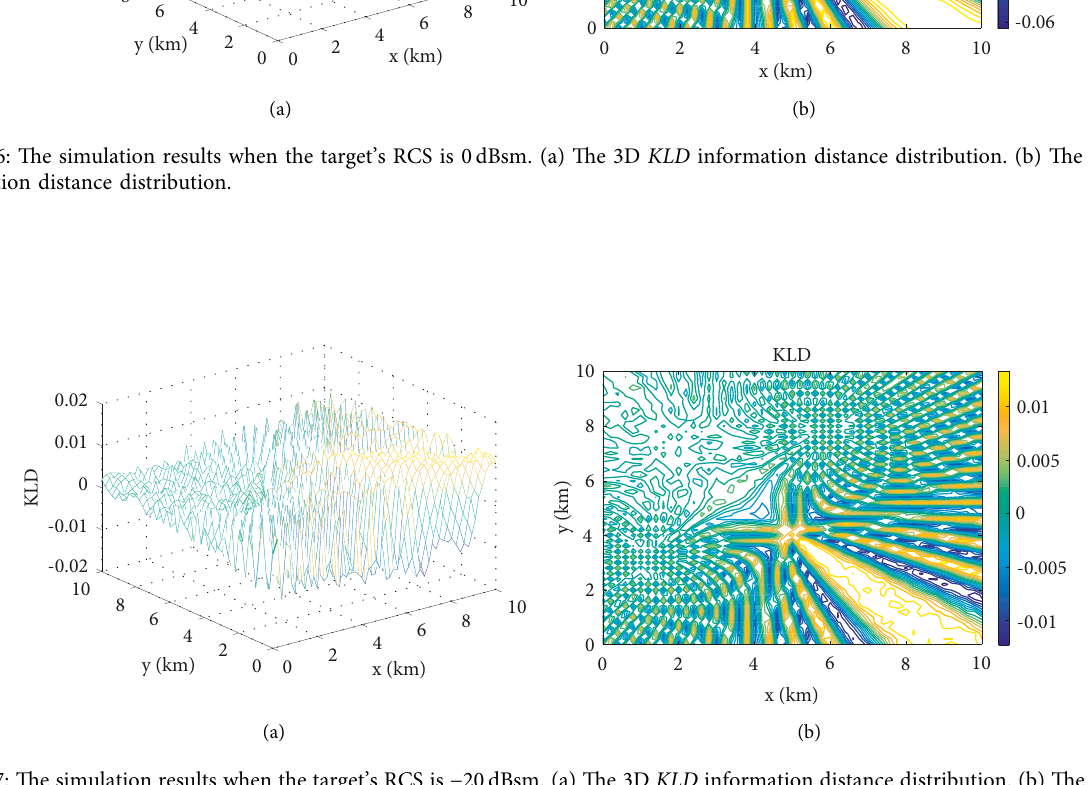
Figure 7: The simulation results when the target’s RCS is − 20dBsm. (a) The 3D KLD information distance distribution. (b) The 2D KLD information distance distribution.